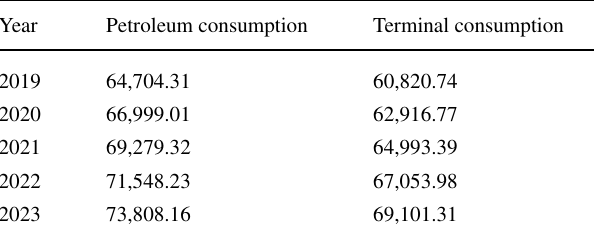
Table 8 Forecast results of China’s petroleum consumption and termi- nal consumption from 2019 to 2023 (10 4